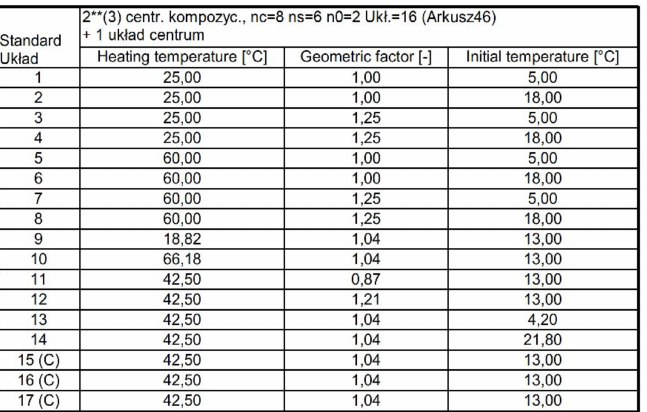
Figure 4. List of experiments necessary to perform, according to the incomplete experiment plan of the Statistica program.